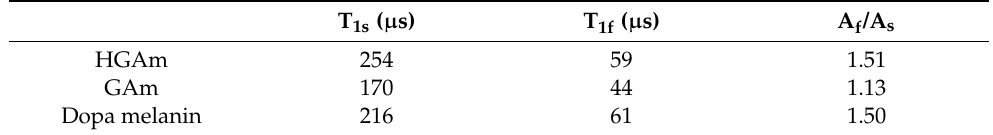
Figure 7. Q-band saturation curves, Θ / Θ 0 ( Θ 0 = 1), obtained from the PFSR experiment performed at room temperature (298 K) on the ( a ) HGAm, ( b ) GAm, and ( c ) Dopa melanin samples, for the determination of T 1 relaxation times. Table 2. Longitudinal relaxation times obtained for HGAm, GAm, and Dopa melanin samples, recorded at room temperature. A biexponential decay was used to interpret the saturation recovery (cid:19) + c. An experimental error of ± 3 µ s can be considered results: y = A f exp in the data reported for the HGAm and Dopa melanin data, while an experimental error of ± 5 µ s has been considered for